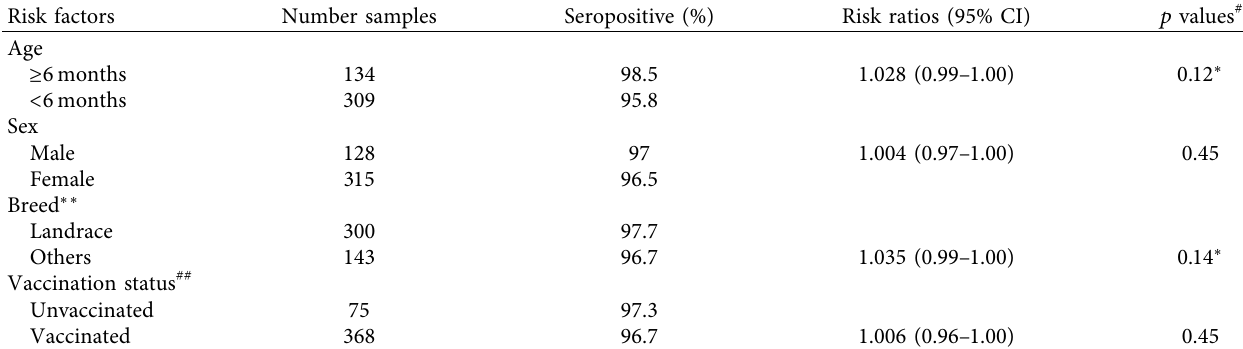
Table 2: Potential association of individual animal-level risk factors of age, sex, breed, and vaccination status with test seroprevalence to JEV.